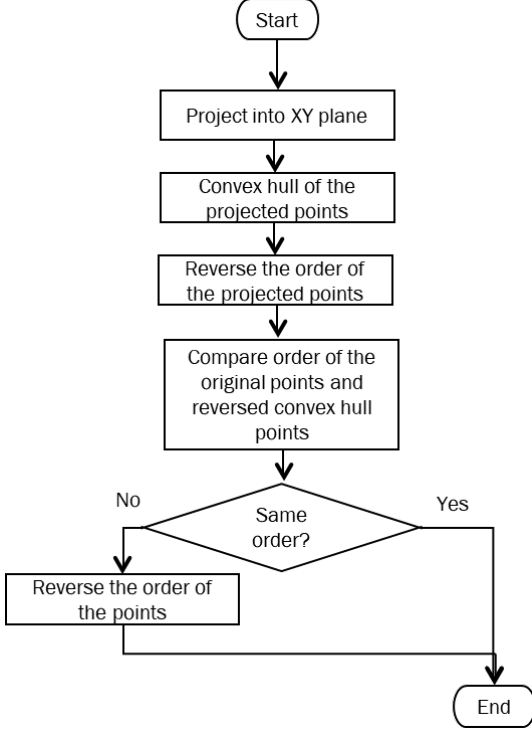
Figure 5. Use of PCL features for counterclockwise ordering.